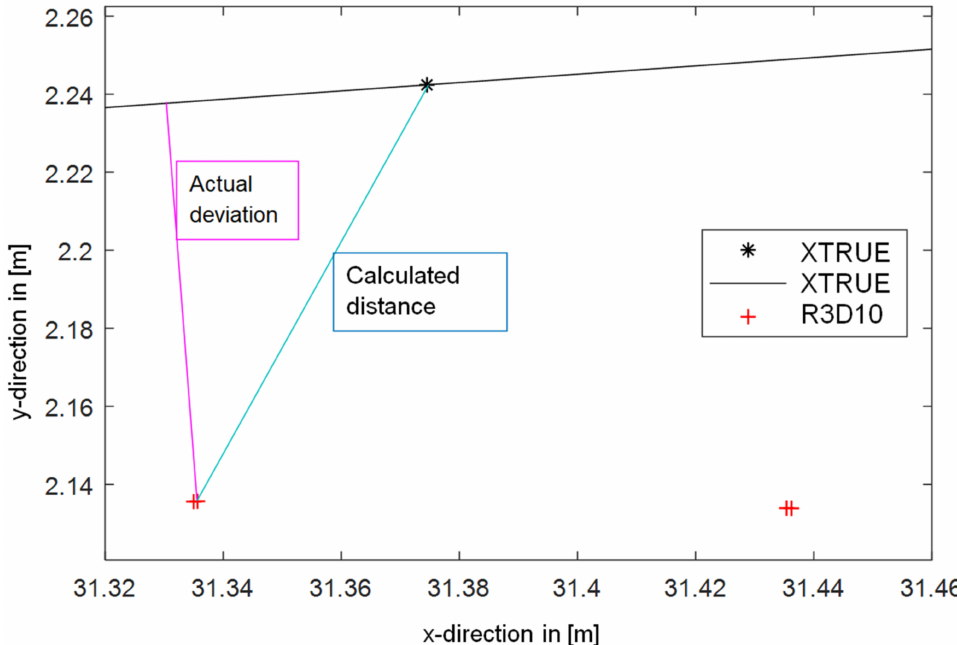
Figure 8. With the 1NN method, the Euclidean calculated distance could only approximate the true distance. Herein, the calculated distance of a point of the trajectory R3D10 is, for example, greater than the actual deviation.